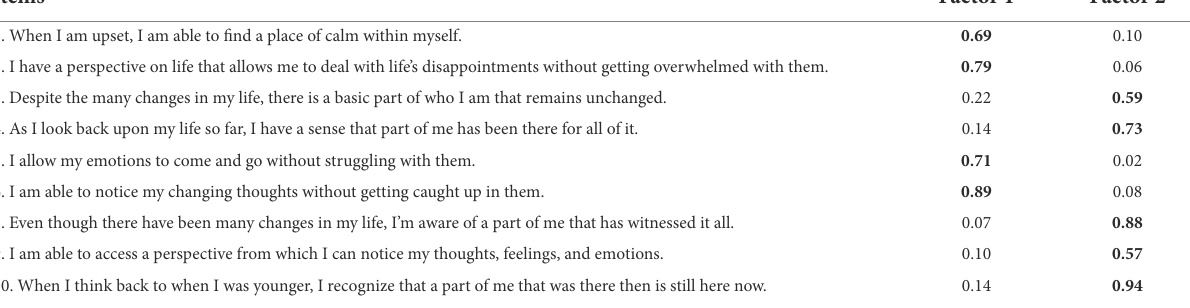
TABLE 2 Factor loadings for exploratory analysis of